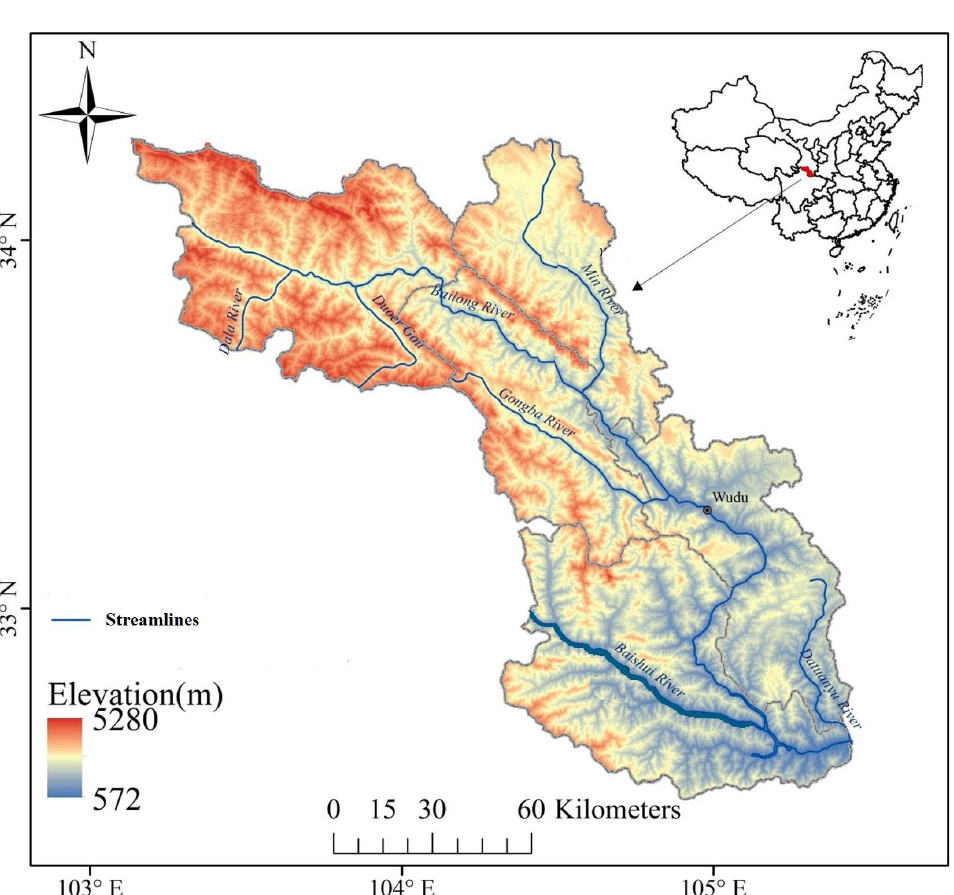
Figure 1. Case study